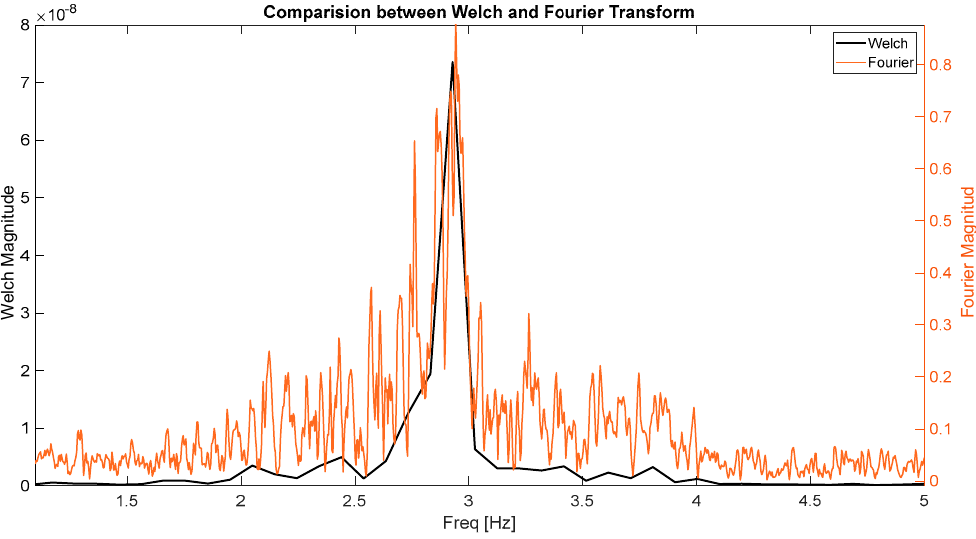
Figure 7. Comparison between the Welch and Fourier spectra.